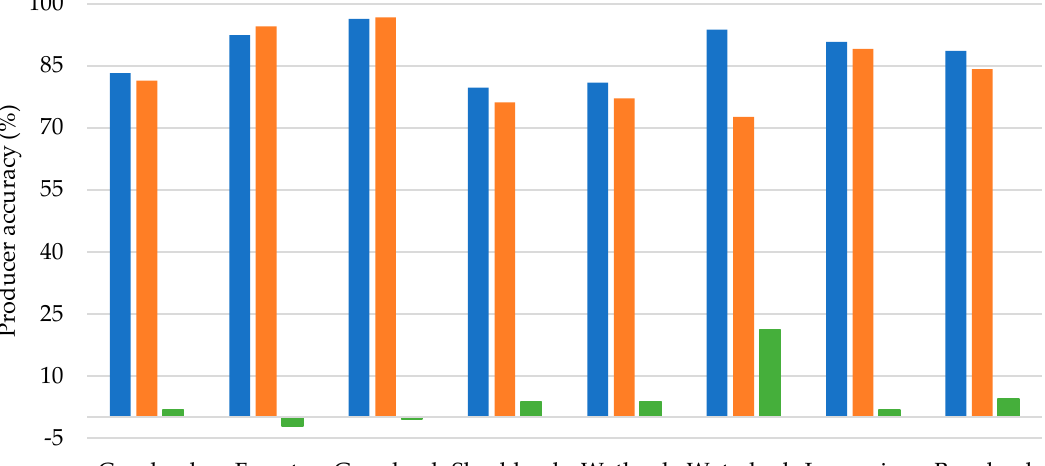
Figure 7. Statistical comparison of producer accuracies (PAs) for the proposed method (i.e., the one tile-based model is applied to one tile) and the conventional method (i.e., one model is applied to the entire study area). The blue and orange bars represent the PAs of eight land cover classes, and the green bars indicate that the differences in PAs.